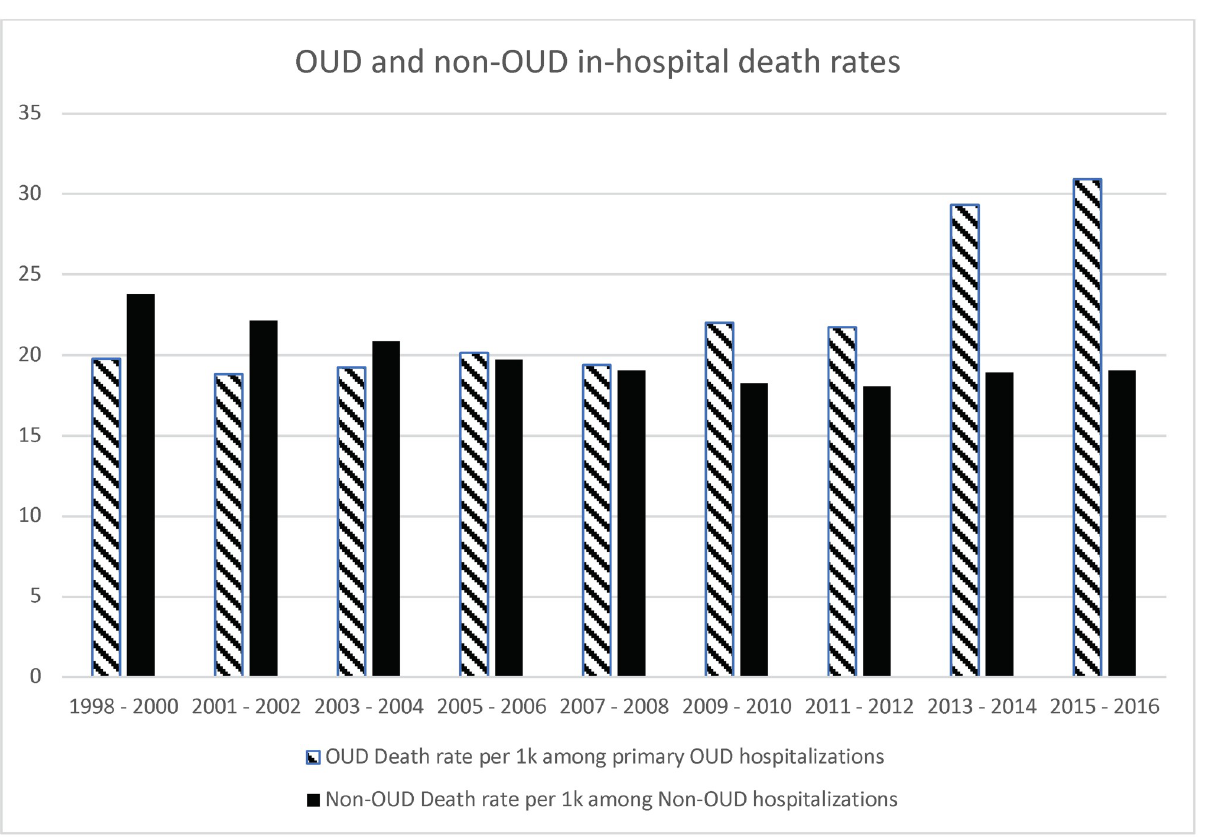
Fig 2. Comparison of OUD vs. non-OUD death rates over the study period from 1998 to 2016. X-axis represents time-periods from 1998–2000 to 2015–16. Y-axis shows the in-hospital death rates per 1k among primary OUD hospitalizations (hashed bars) and among all NIS hospitalizations except OUD (solid